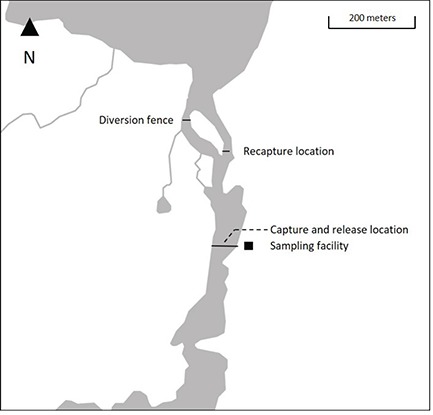
Map of the Campbellton River study site with location of capture and release, sampling and recapture of Atlantic salmon kelts.